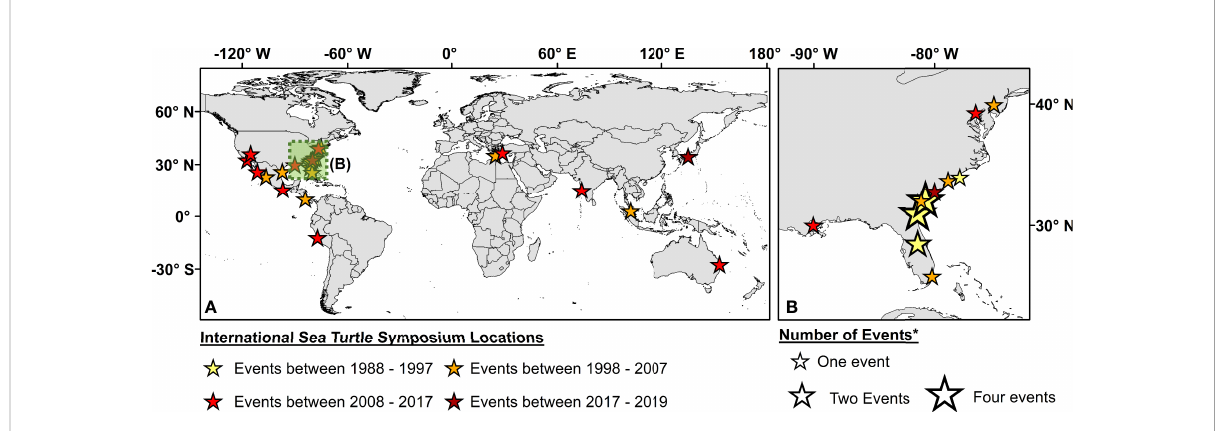
FIGURE 1 (A) Location of all International Sea Turtle Symposiums between 1988 – 2019. (B) A zoomed in image of the East Coast of the USA to better re fl ect the high concentration of events that have occurred in this region. Larger stars represent locations where events have been held at the same location over multiple